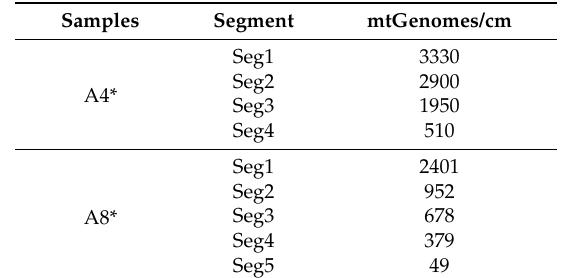
Table 8. mtDNA quantitation values and degradation Index values for two single aged segmented hairs. The asterisk denotes DNA extraction using protocol B. No degradation index was obtained for any of the